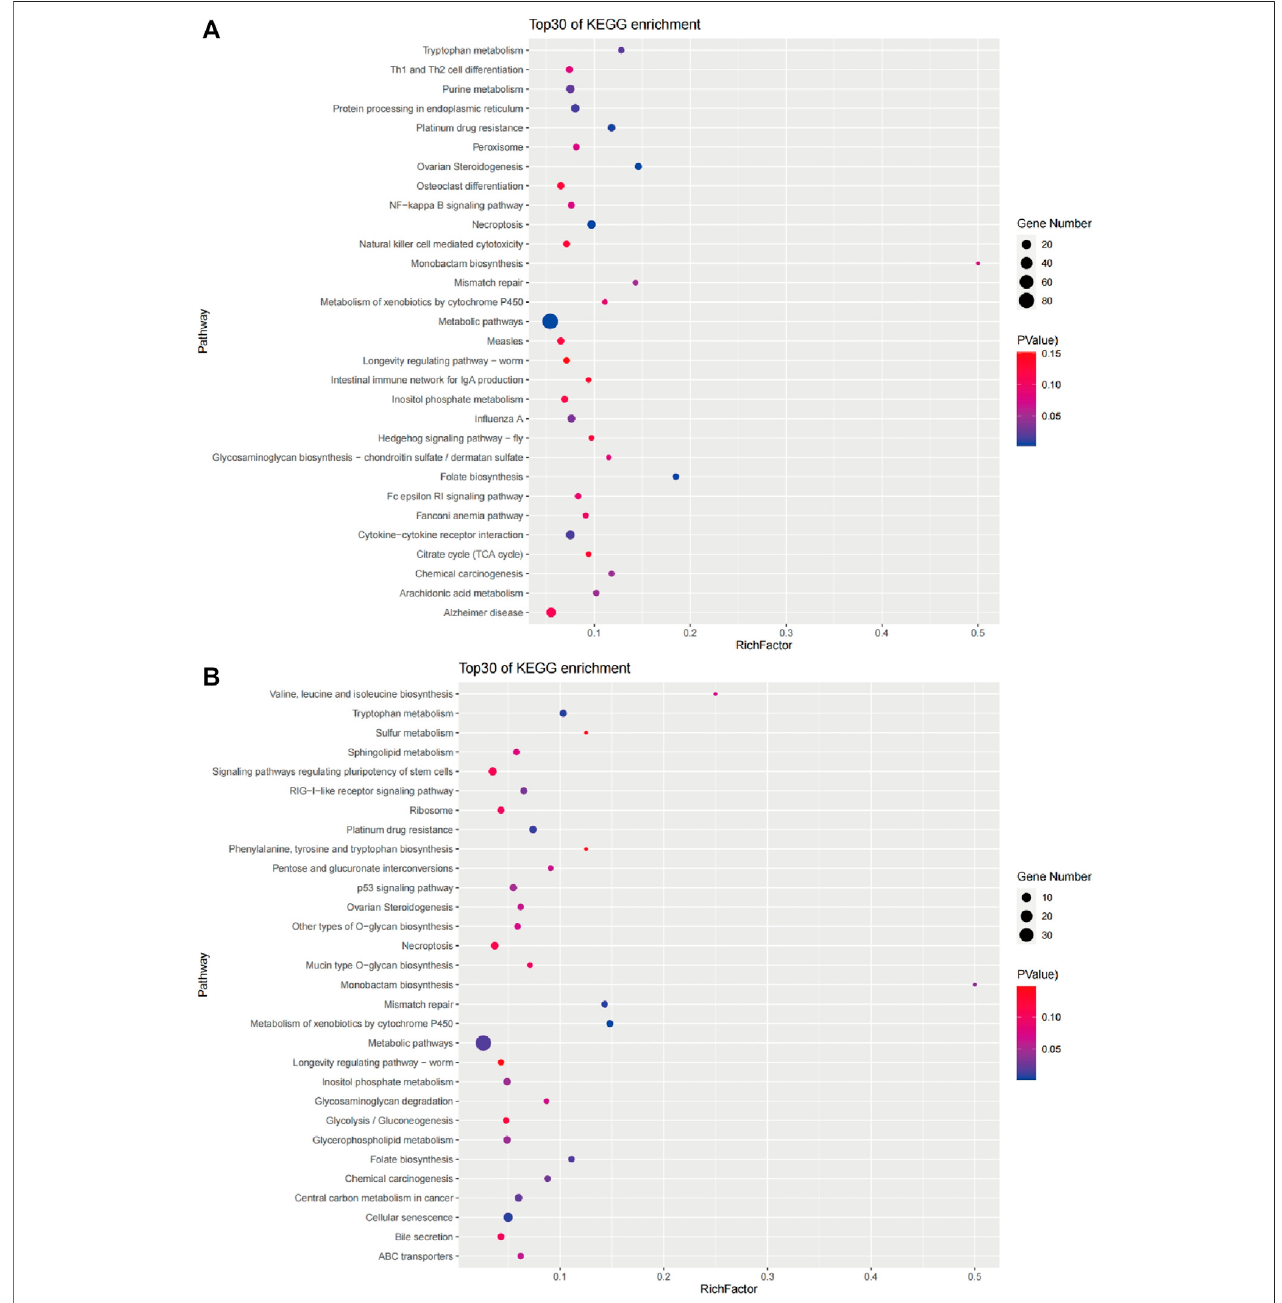
FIGURE 7 | The top 30 pathways enriched by candidate genes of the brain (A) and liver (B) .